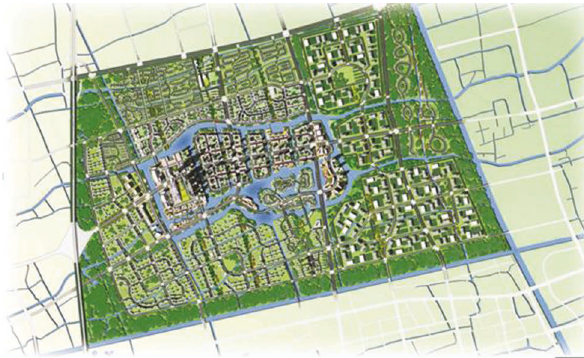
Figure 3: Plan of Pudong activity